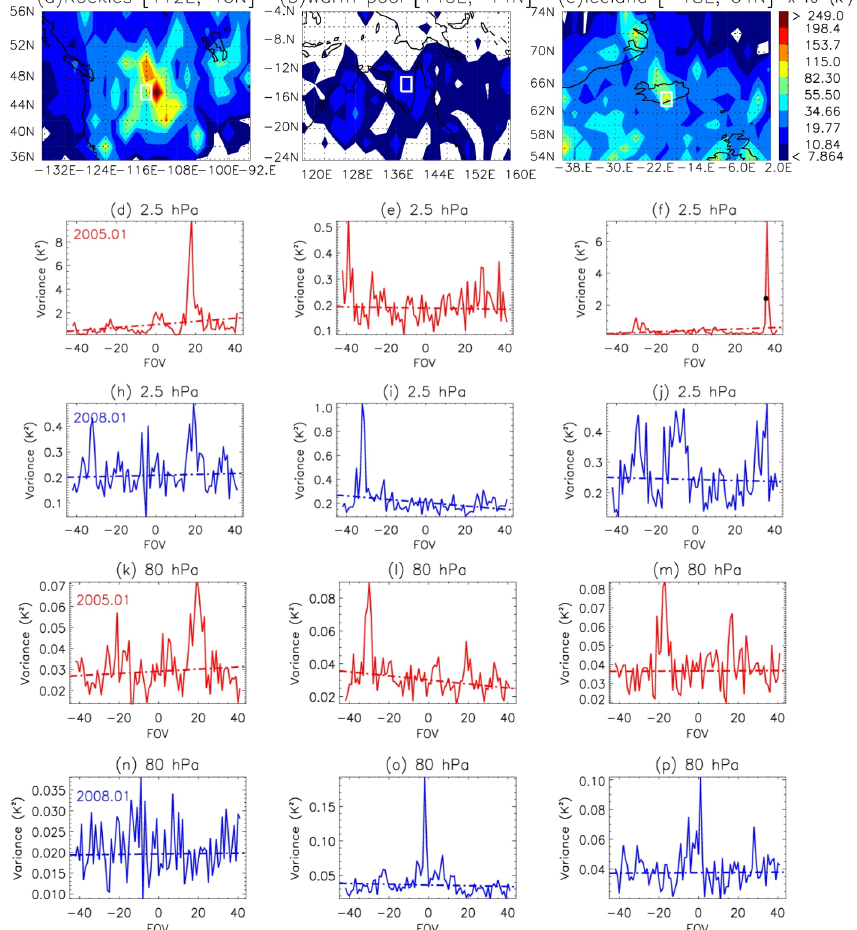
Fig. 8. (a–c) Geographical map of GW variance at eastmost view at three different locations for January 2005 at 2.5hPa. The GW variances within the white box of (a–c) as a function of FOV numbers are plotted in solid for each location at (d–f) January 2005, 2.5hPa; (h–j) January 2008, 2.5hPa; (k–m) January 2005, 80hPa; and (n–p) January 2008, 80hPa. Negative (positive) FOV numbers correspond to west (east) views, and 0 corresponds to nadir view. The linear fits of each FOV curve are overplotted in dash-dotted lines.